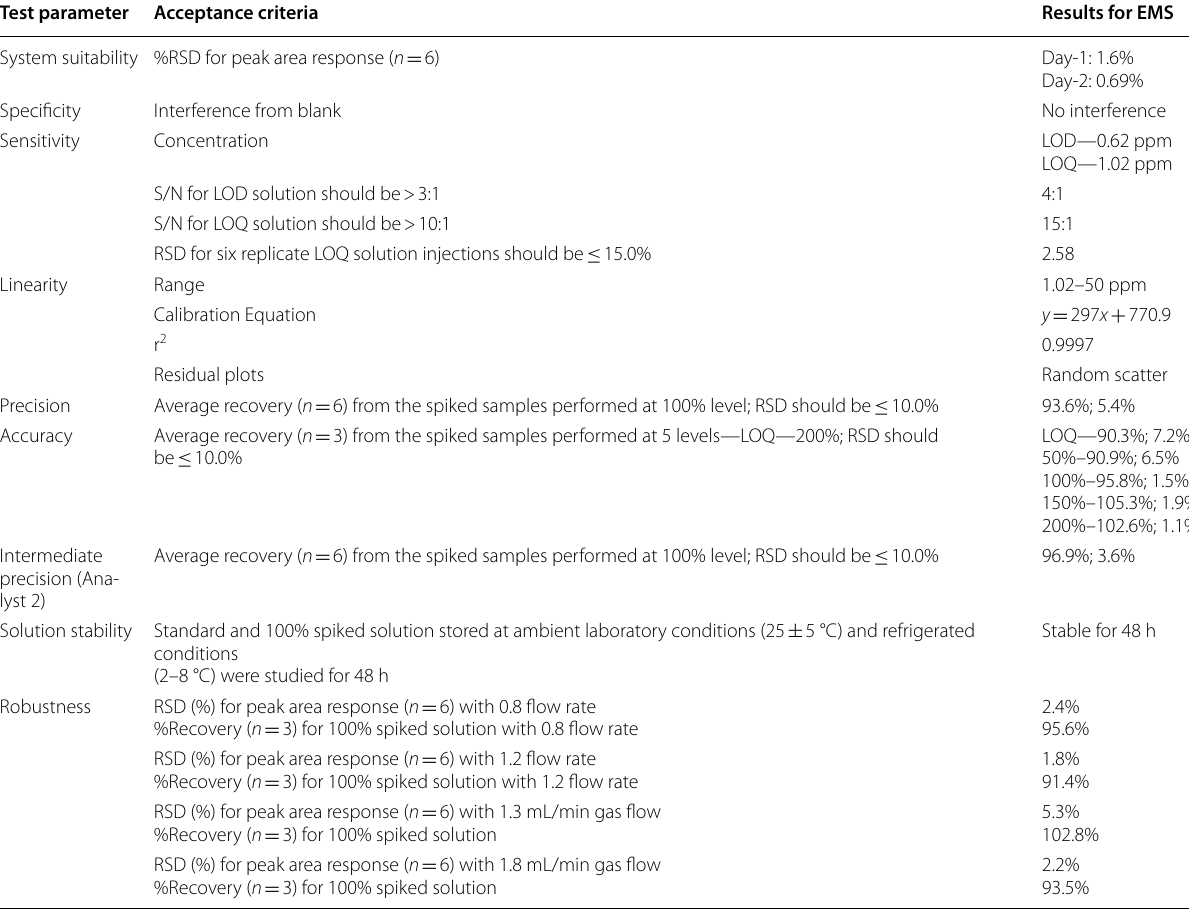
Table 2 Summary of data obtained from method validation Test parameter Acceptance